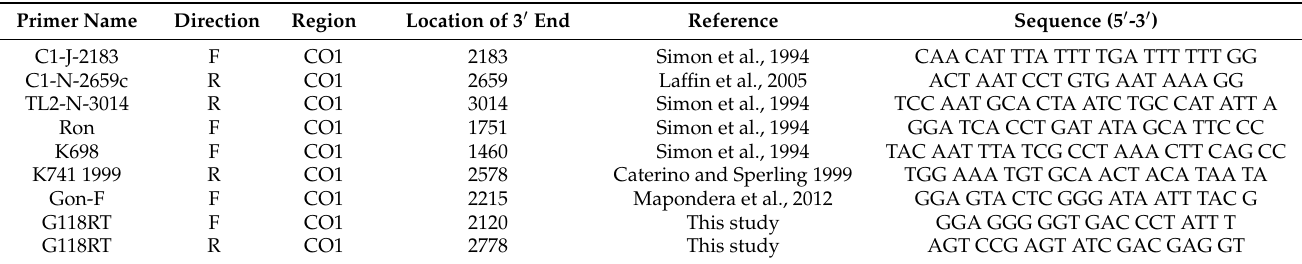
Table 1. Primers used for PCR amplification and sequencing of the Gonipterus